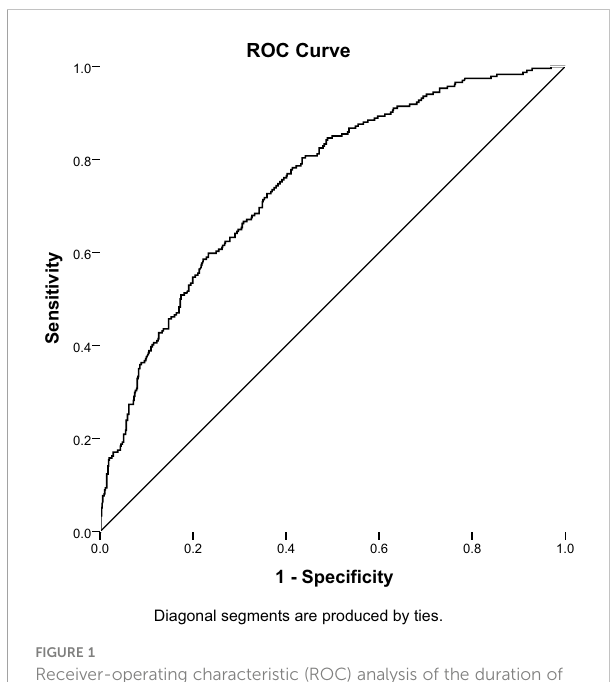
TABLE 4 Pearson ’ s correlation analysis of nerve conduction with RFMI.